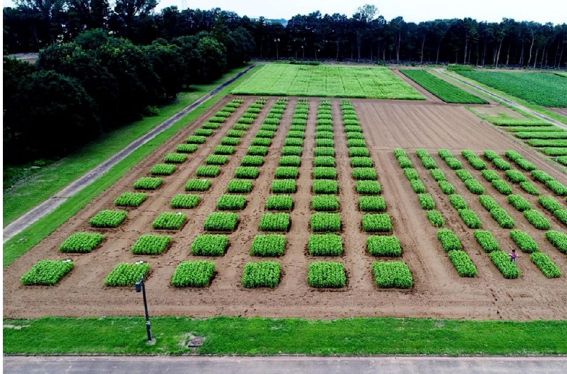
Figure 12. Target field of the second